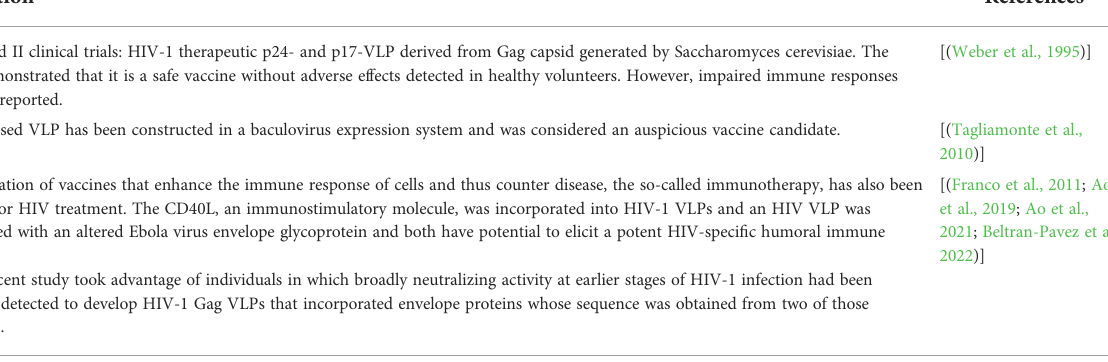
TABLE 1 VLP-based vaccines for HIV-1 (Weber et al., 1995; Tagliamonte et al., 2010; Franco et al., 2011; Ao et al., 2019; Ao et al., 2021; Beltran- Pavez et al., 2022).